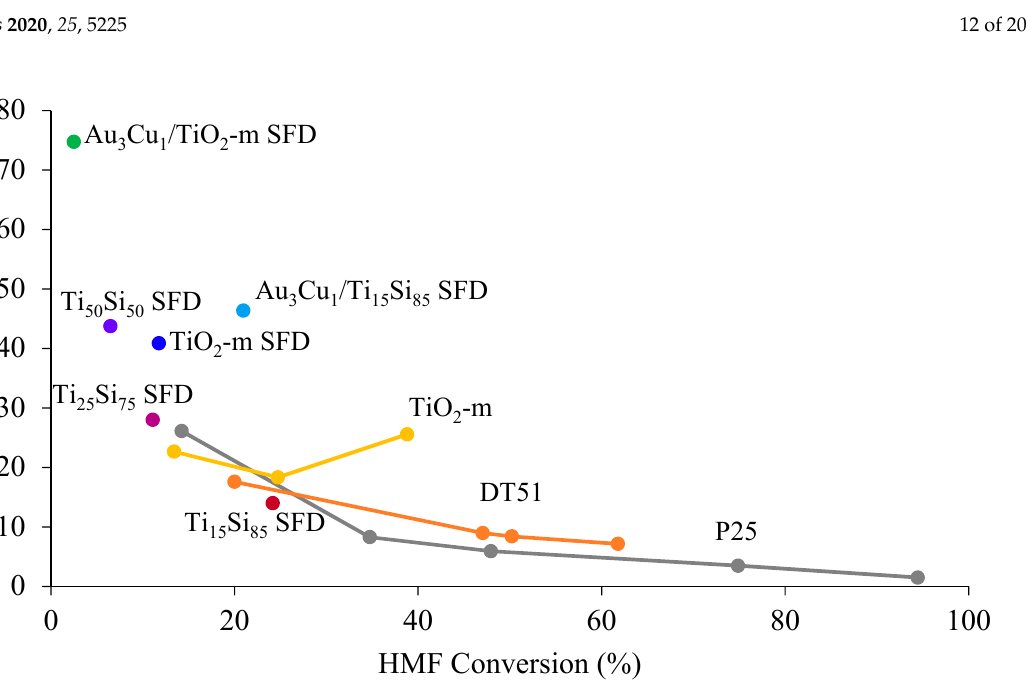
Figure 8. Effect of conversion on the total products selectivity of different titania-based photocatalysts.